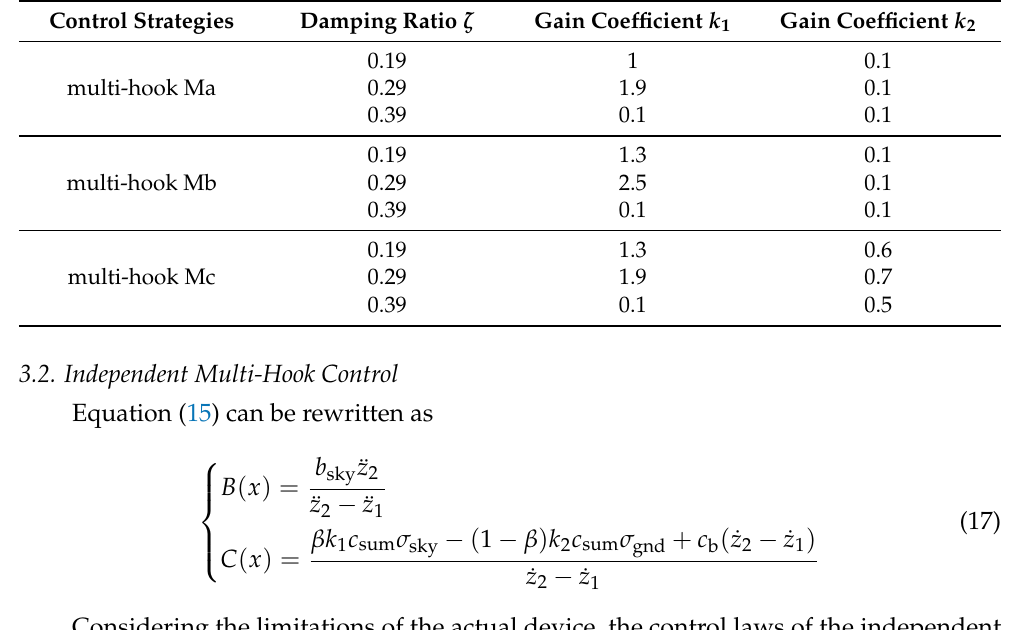
Table 4. Optimization results of damping gain